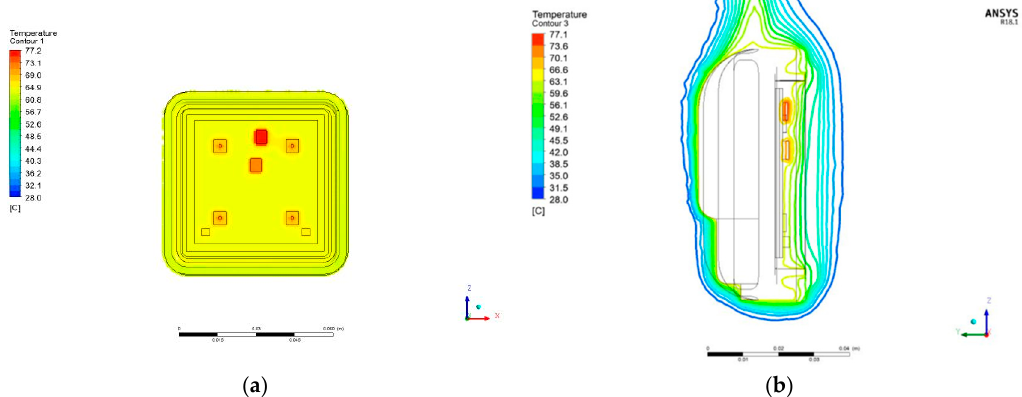
Figure 13. Simulation result of the 48 V power LED. ( a ) Temperature field of the 48 V LED. ( b ) Isotherm diagram of 48 V power LED.